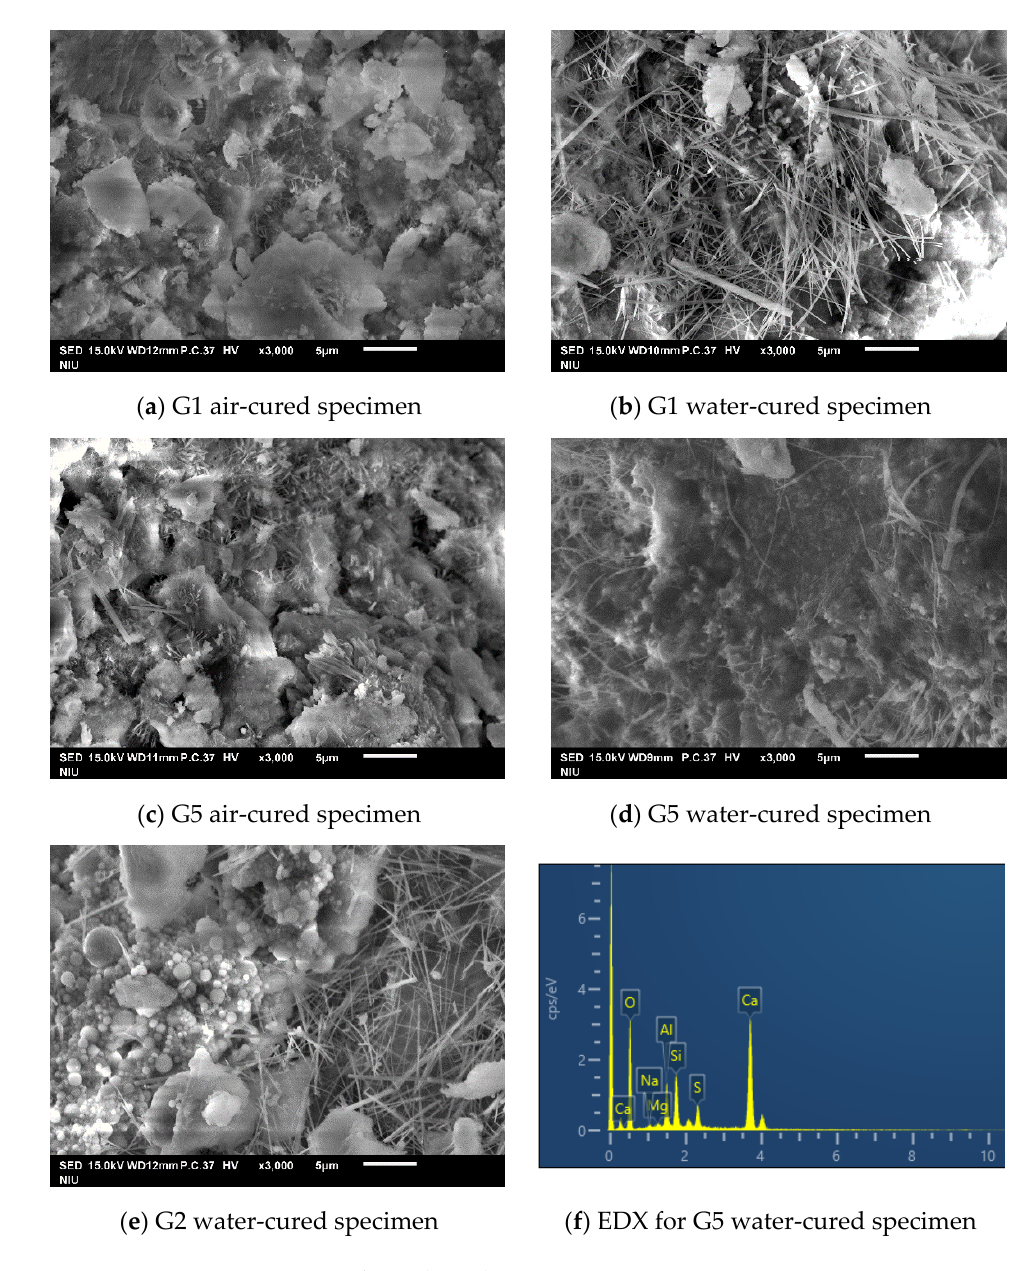
Figure 1. SEM photos (x3000).